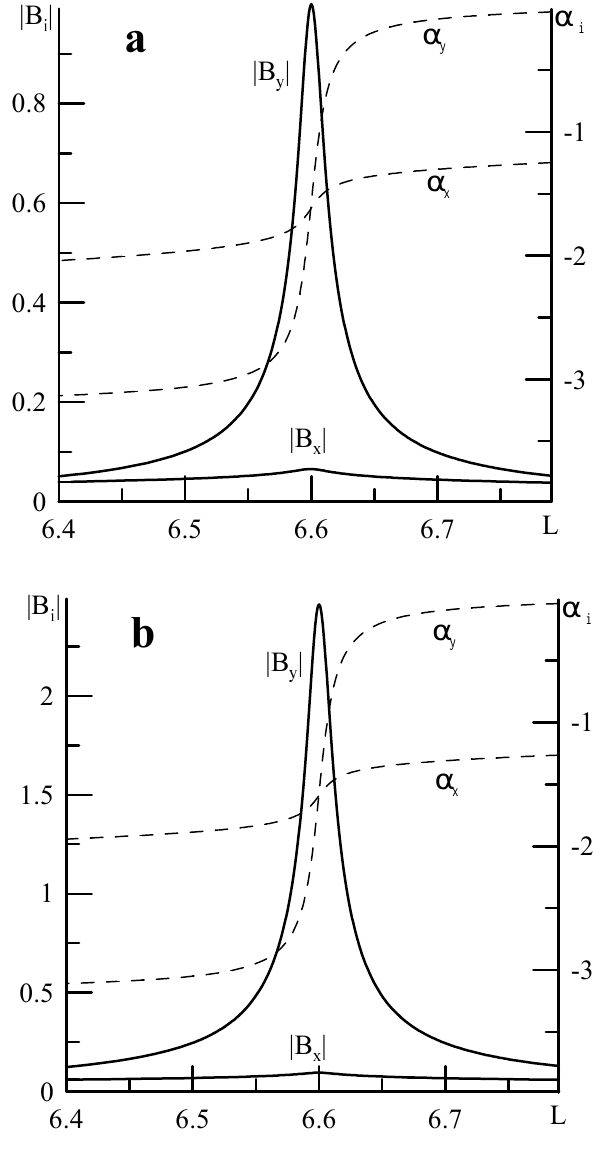
Fig. 6. Transverse structure of magnetic components of the fun- damental ( N = 1) Alfv´en oscillations in the region of “classical” Alfv´en field line resonance at L = 6 . 6 (compare with Fig. 5): the dis- tribution of the wave amplitude | B i | and phase α i ,(i = x,y) close to the equatorial plane (a) and above the ionosphere (b)